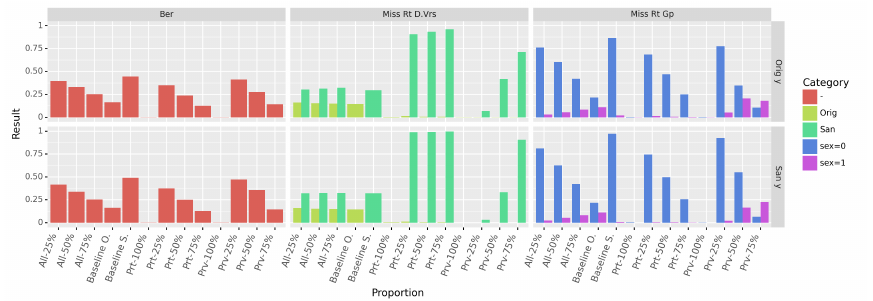
Figure 11. BER and miss prediction rates of GB (trained to predict the sensitive attribute on Adult). From left to right: BER, miss prediction rate on the original and sanitized part of the mixed data, miss prediction rate per groups. The standard deviation for all computed results is below 0.05.